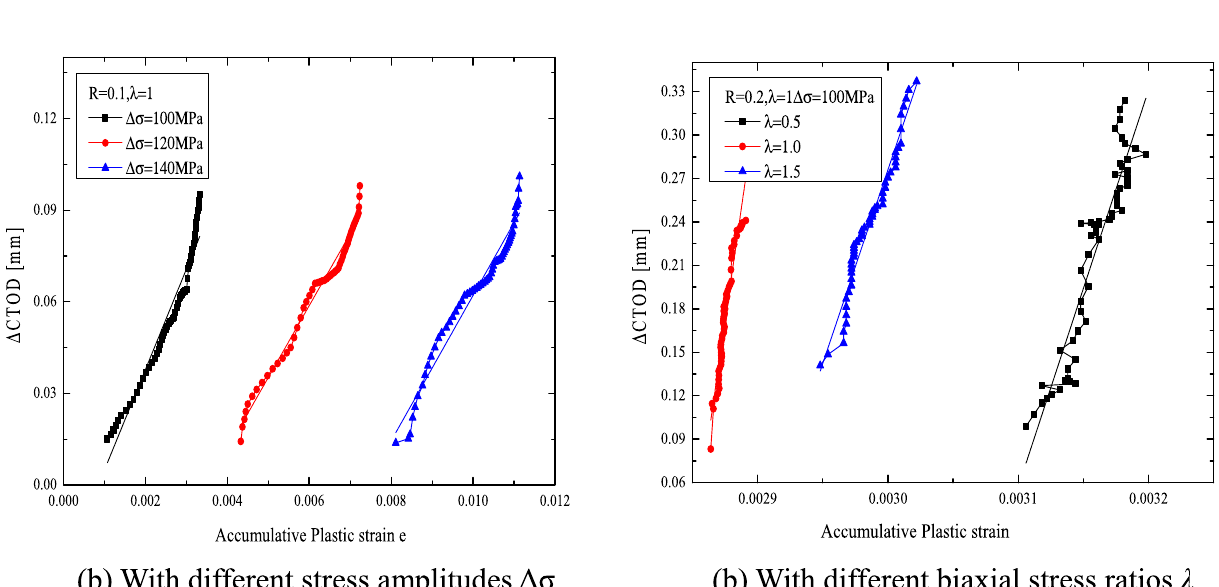
Fig. 12 Relationships curves between ΔCTOD and accumulative plastic strain rate under different biaxial